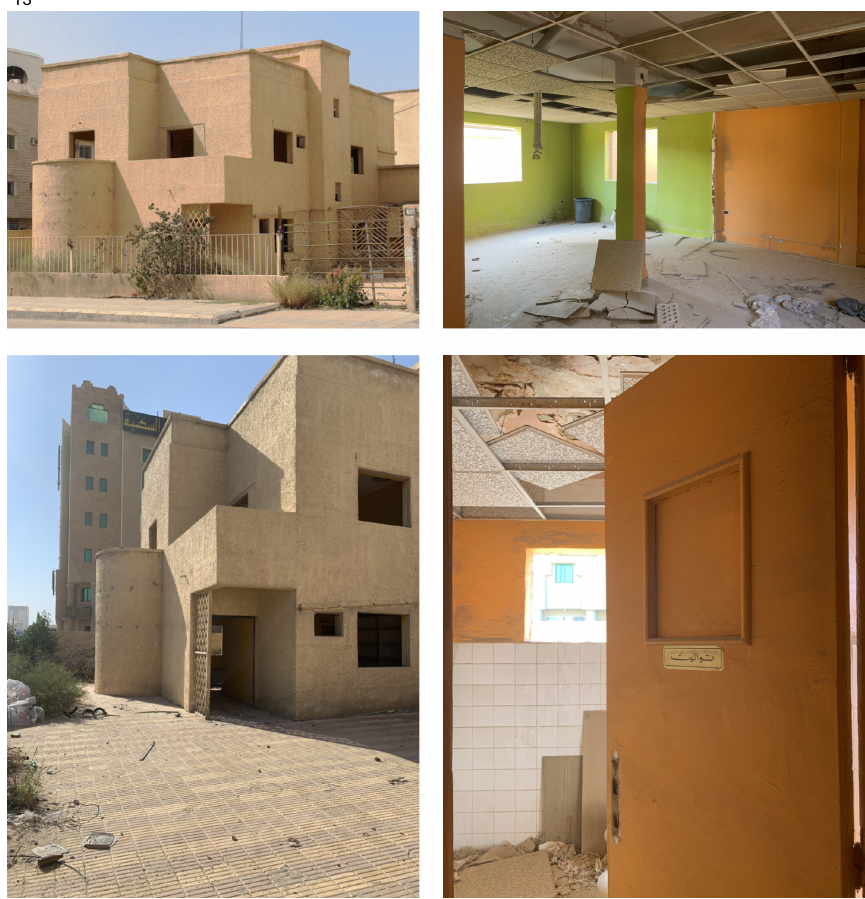
Fig. 13 Photos of the current condition of the Arabian Engineering Company (Aren) prototype house, built for the government employees in Al-Malaz. Photo- graph by